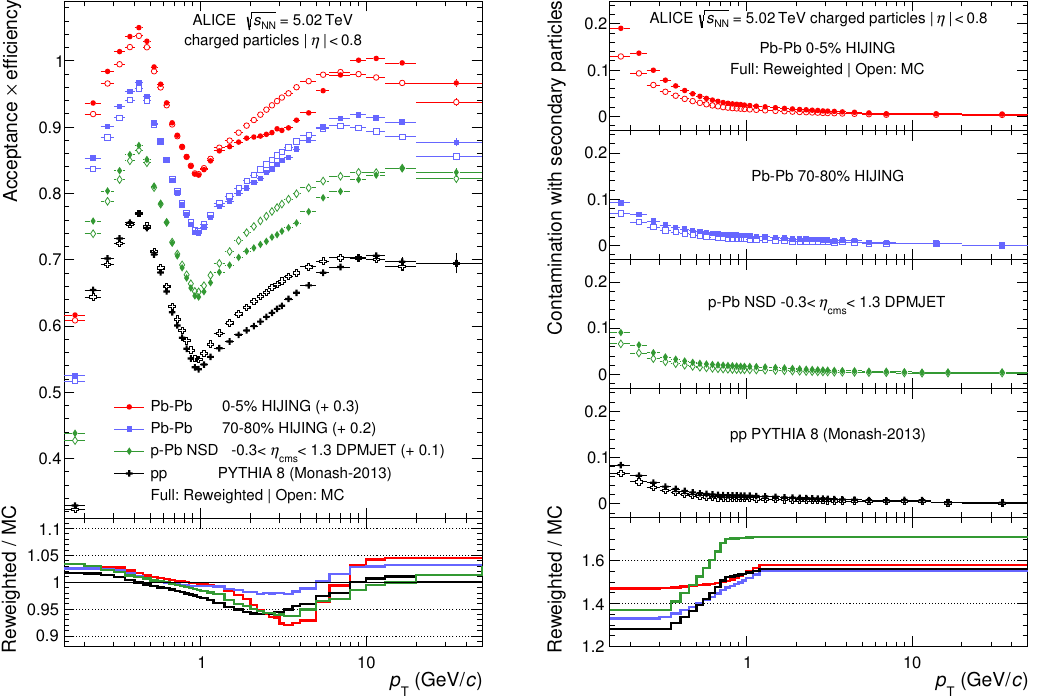
Figure 2 . Left: combined tracking e(cid:14)ciency and acceptance as a function of p T for pp, p-Pb, central (0{5%) and peripheral (70{80%) Pb-Pb collisions determined using Monte Carlo simulations and a reweighting method (see text for details). For better visibility, the curves for p-Pb and Pb-Pb are o(cid:11)set by the indicated values. The e(cid:11)ect of the reweighting on the e(cid:14)ciency corrections is shown in the bottom panel. The systematic uncertainties of the reweighting ( < 2 : 4%) are not shown. Right: contamination from secondary particles estimated from Monte Carlo simulations and from the impact parameter (cid:12)ts in data (see text for details). The e(cid:11)ect of the reweighting of secondary particles is shown in the bottom panel. The systematic uncertainties on the scaling factors ( < 20%) are not